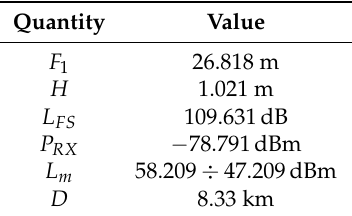
Table 3. Values of the quantities introduced in Section 4.